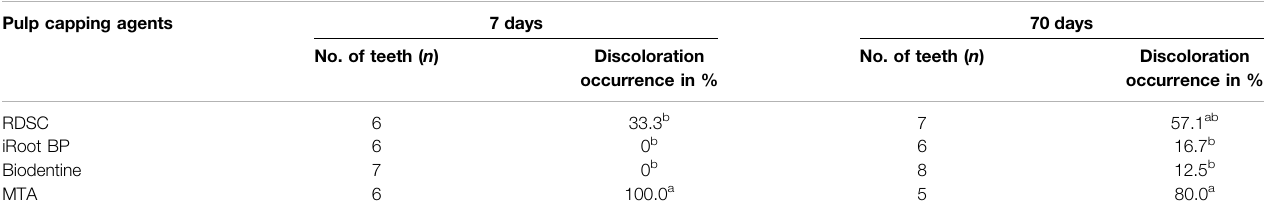
TABLE 1 | The occurrence rates of discoloration for different materials using in-vivo miniature pig model. Means with different small letters in the same column indicate a signi fi cant difference ( p < 0.05). Pulp capping